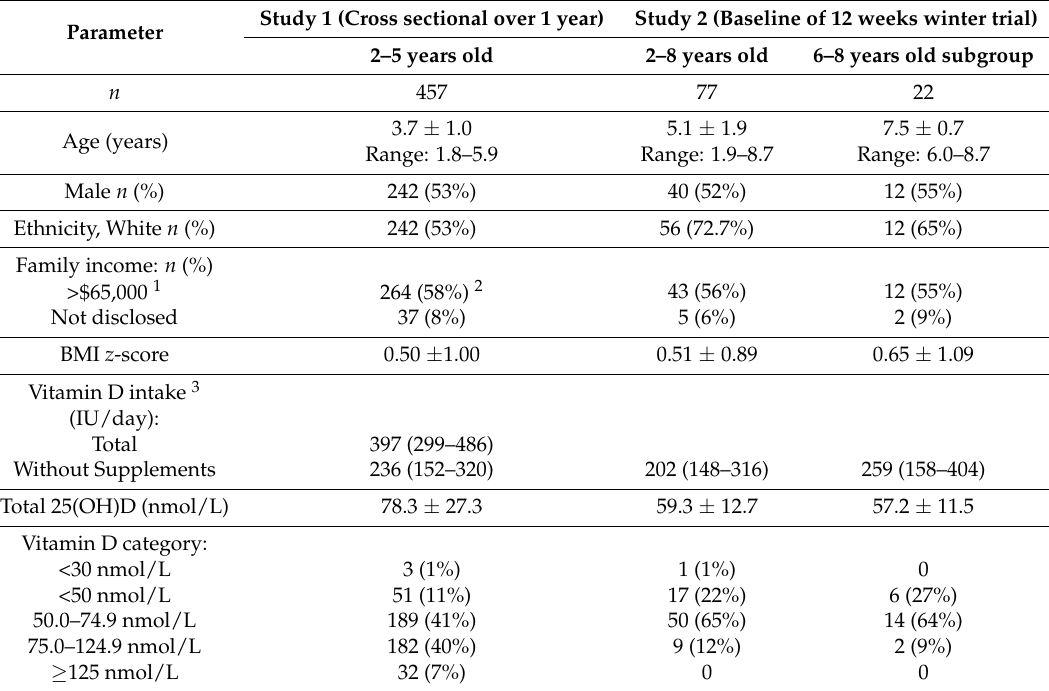
Table 1. Characteristics of young children assessed for vitamin D status.